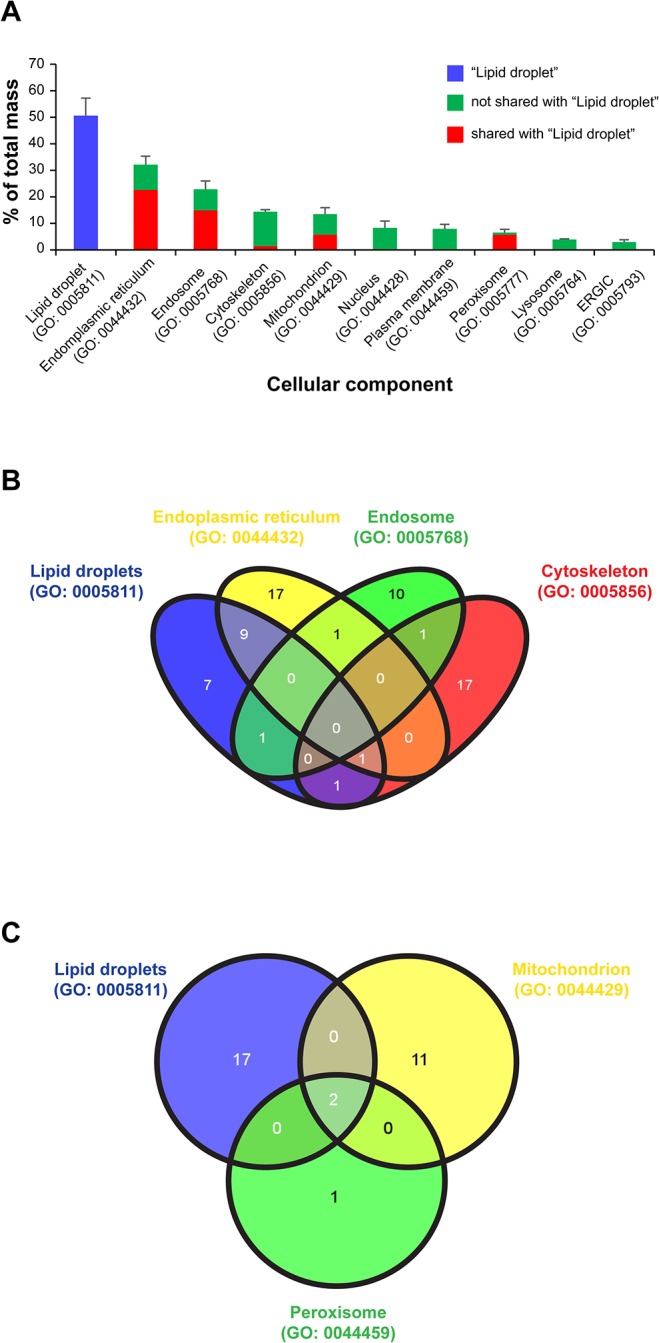
Cellular component analysis of LD-associated proteins.
(A) All LD-associated proteins identified and quantified in this study were classified based on their gene ontologies (GO) by “cellular component” using UniProtKB. The quantitative contribution of each protein group (average across all samples) was calculated and expressed as percent of the total mass of LD-associated proteins. Only the quantitatively more abundant categories are represented (see S5 Table for a detailed list). Because a given protein can be classified in more than one GO category, there is some degree of overlap between the groups and thereby the sum of all categories exceeds one hundred percent. The quantitative contribution of proteins belonging to the “lipid droplet” category (GO: 0005811) as well as that corresponding to proteins “shared” and “not shared” between the “lipid droplet” and the other specified categories are indicated. (B, C) Venn diagrams show the number of overlapping proteins between “lipid droplets” and other selected cellular components.